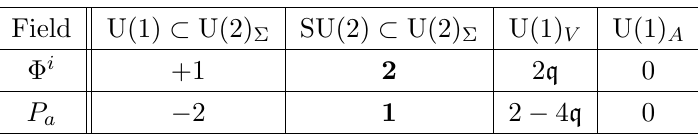
Table 3 . The U(2) (cid:6) gauge representation, U(1) V and U(1) A R-charge of matter (cid:12)elds P a , (cid:8) i for a; i = 1 ; 2 : : : ;